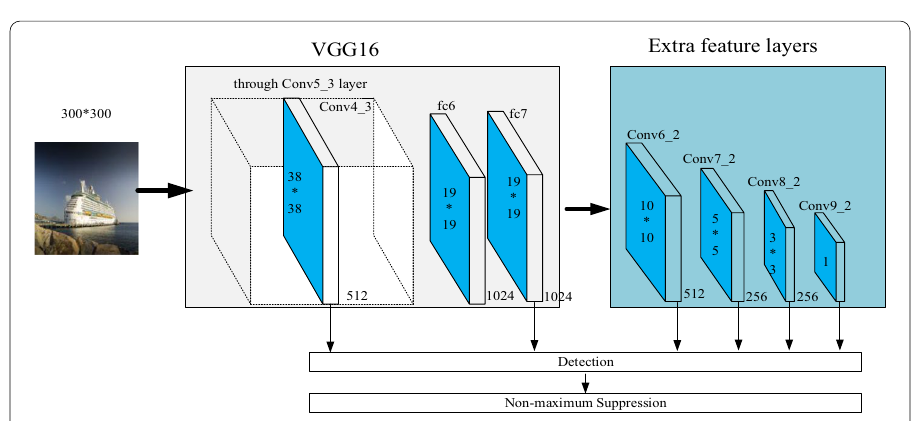
Fig.2 SSD algorithm structure